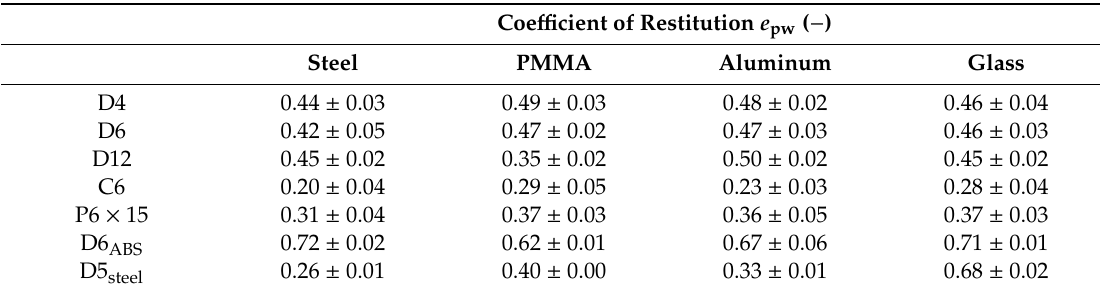
Table 11. Results of particle-wall CoR values.